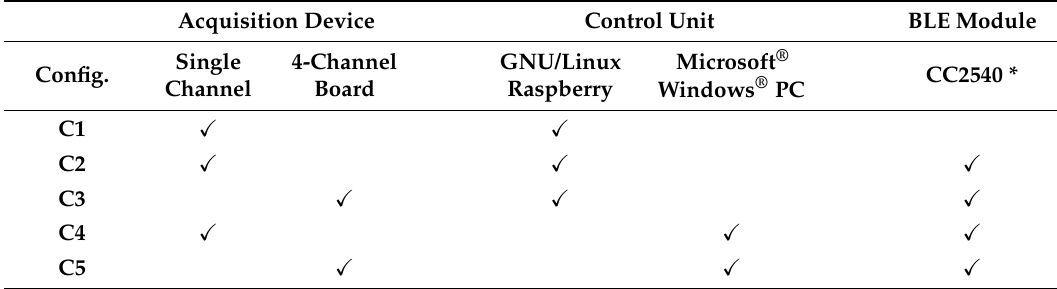
Table 1. Tested hardware configurations. Main differences concern the acquisition device (single